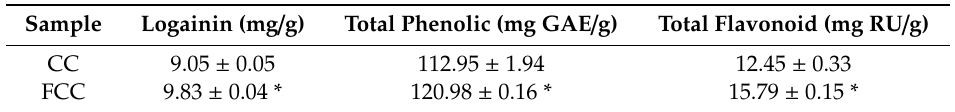
Figure 1. ( a ) HPLC profiles of the loganin standard for Cornus o ffi cinalis (CC) and fermented CC (FCC), ( b ) the structure of loganin. Table 3. Total phenolic and flavonoid contents of CC and FCC. All data were expressed as the mean ± SD, n = 3. * p < 0.05 compared to CC